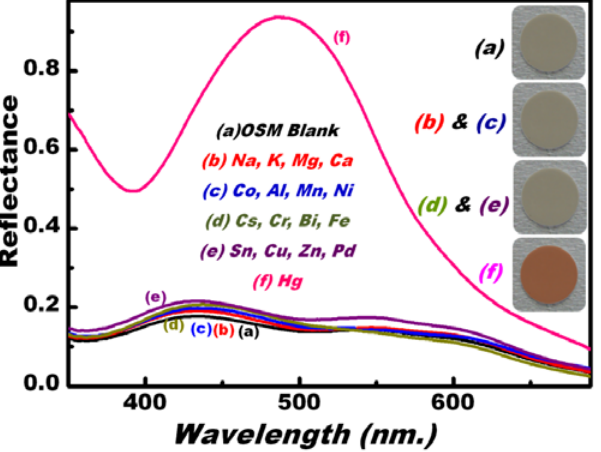
Figure 4. Selectivity studies of OSM for [500 ppb]Hg(II) ion removal carried out in groups at pH 5, 20 mL total volume, and 20 °C temperature. Sequential color and reflectance signaling at characteristic λ max = 485 nm, indicating the response to the OSM sensor